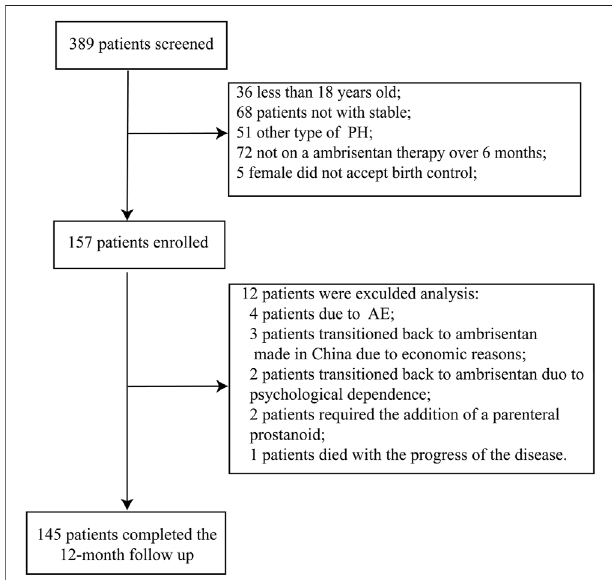
FIGURE 1 | Flow chart of patients